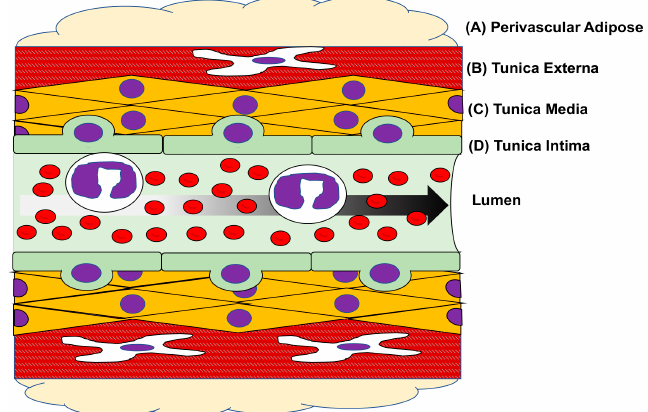
Figure 2. Layers of a blood vessel. Cartoon cross-sectional image of a blood vessel with major